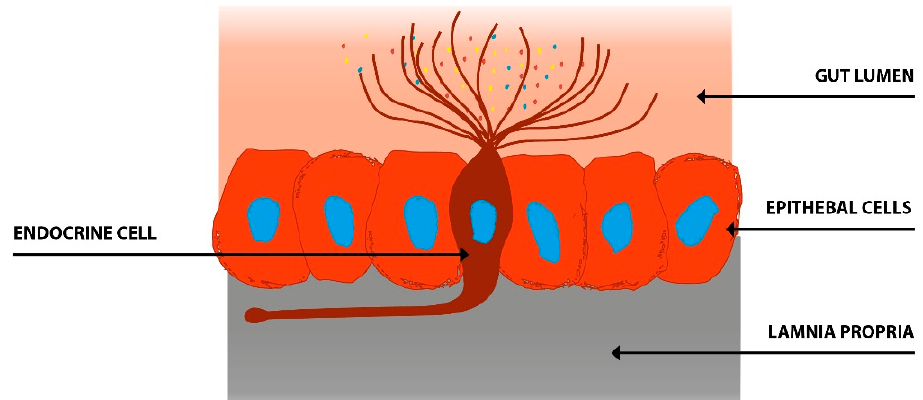
Figure 2. The gut endocrine cells have specialized microvilli that project into the gut lumen and act as sensors for the gut contents (mostly for nutrients). They respond to luminal content by releasing their hormones into the lamina propria. These hormones act locally on nearby structures (paracrine mode of action) or enter the blood stream and act on more distant structures (endocrine mode of action).